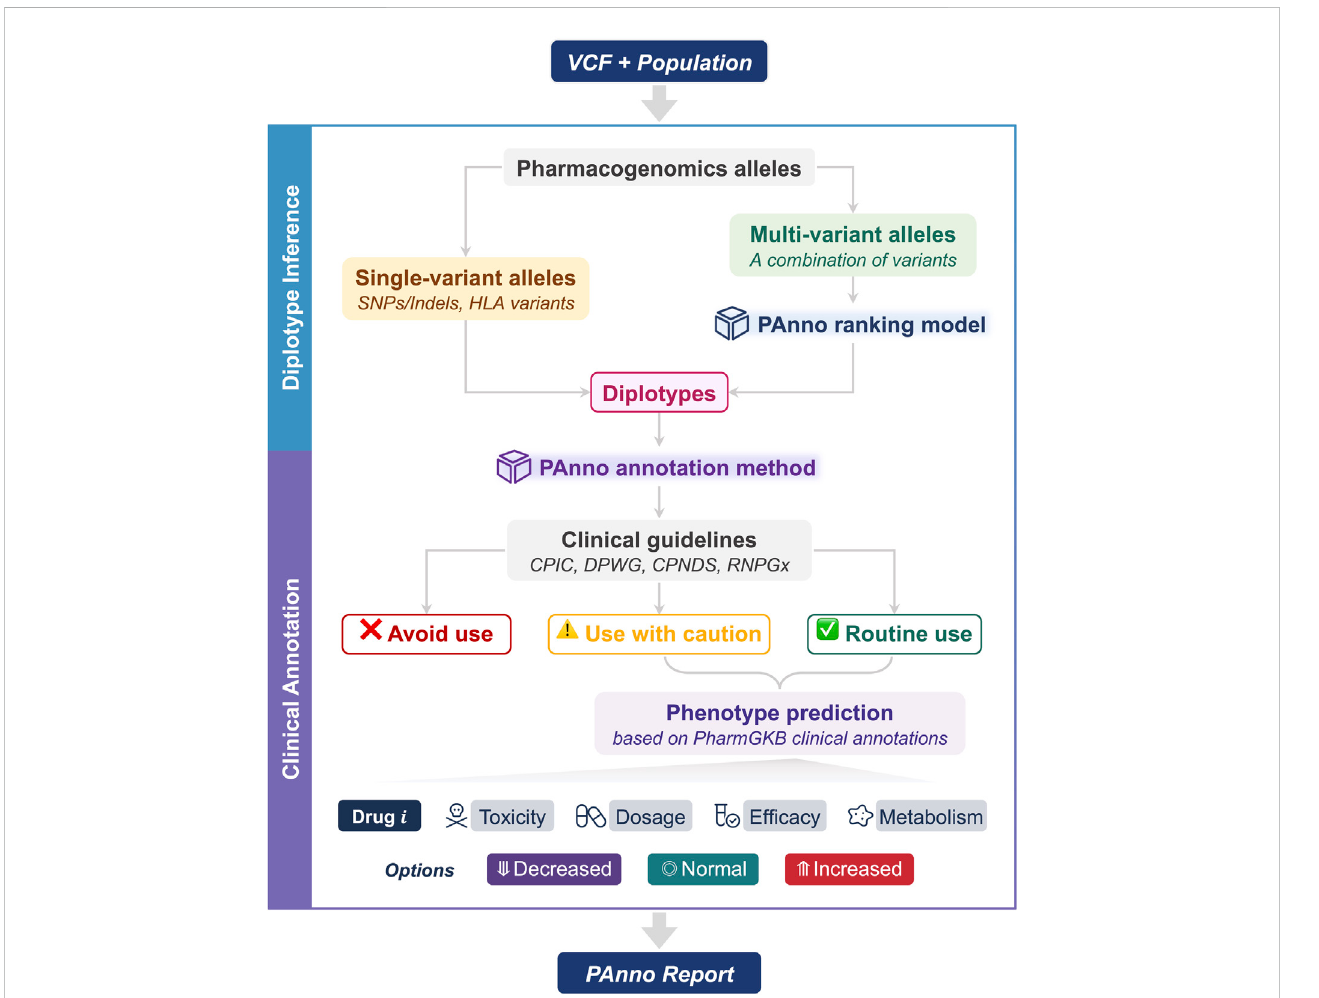
FIGURE 1 The architecture of PAnno. PAnno parses the user-submitted VCF with its af fi liated population and outputs a pharmacogenomics (PGx) report. PAnno classi fi esPGxallelesintheVCFintosingle-variantallelesandmulti-variantalleles.Diplotypesfortheformercanbederiveddirectly,whilethelatterwillcallthe PAnno ranking model for inference. Based on the inferred diplotypes, the PAnno annotation method fi rst determines the availability of drugs according to clinical guidelines. Afterwards, it integrates the effects of multiple diplotypes on the same drug to predict drug response phenotypes in terms of toxicity, dosage, ef fi cacy, and